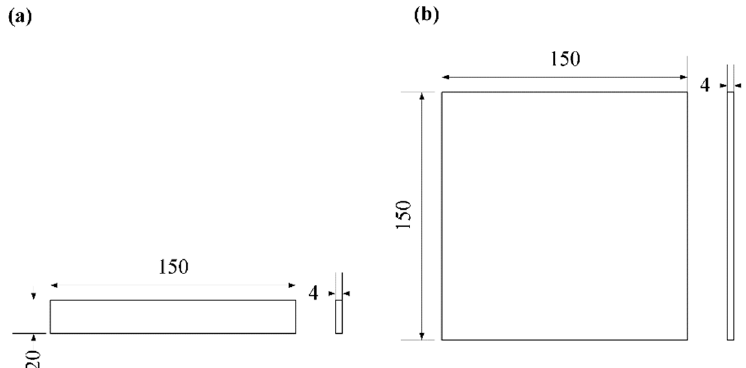
Figure 2. Geometric models of the precision test specimens. ( a ) dimensional accuracy; ( b ) warpage.